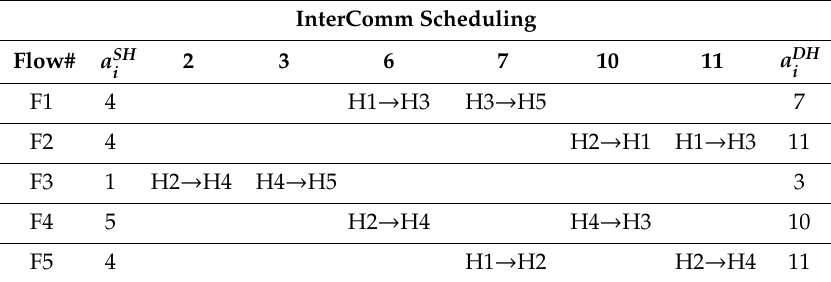
Table 5. Results of proposed scheme InterComm scheduling of Figure